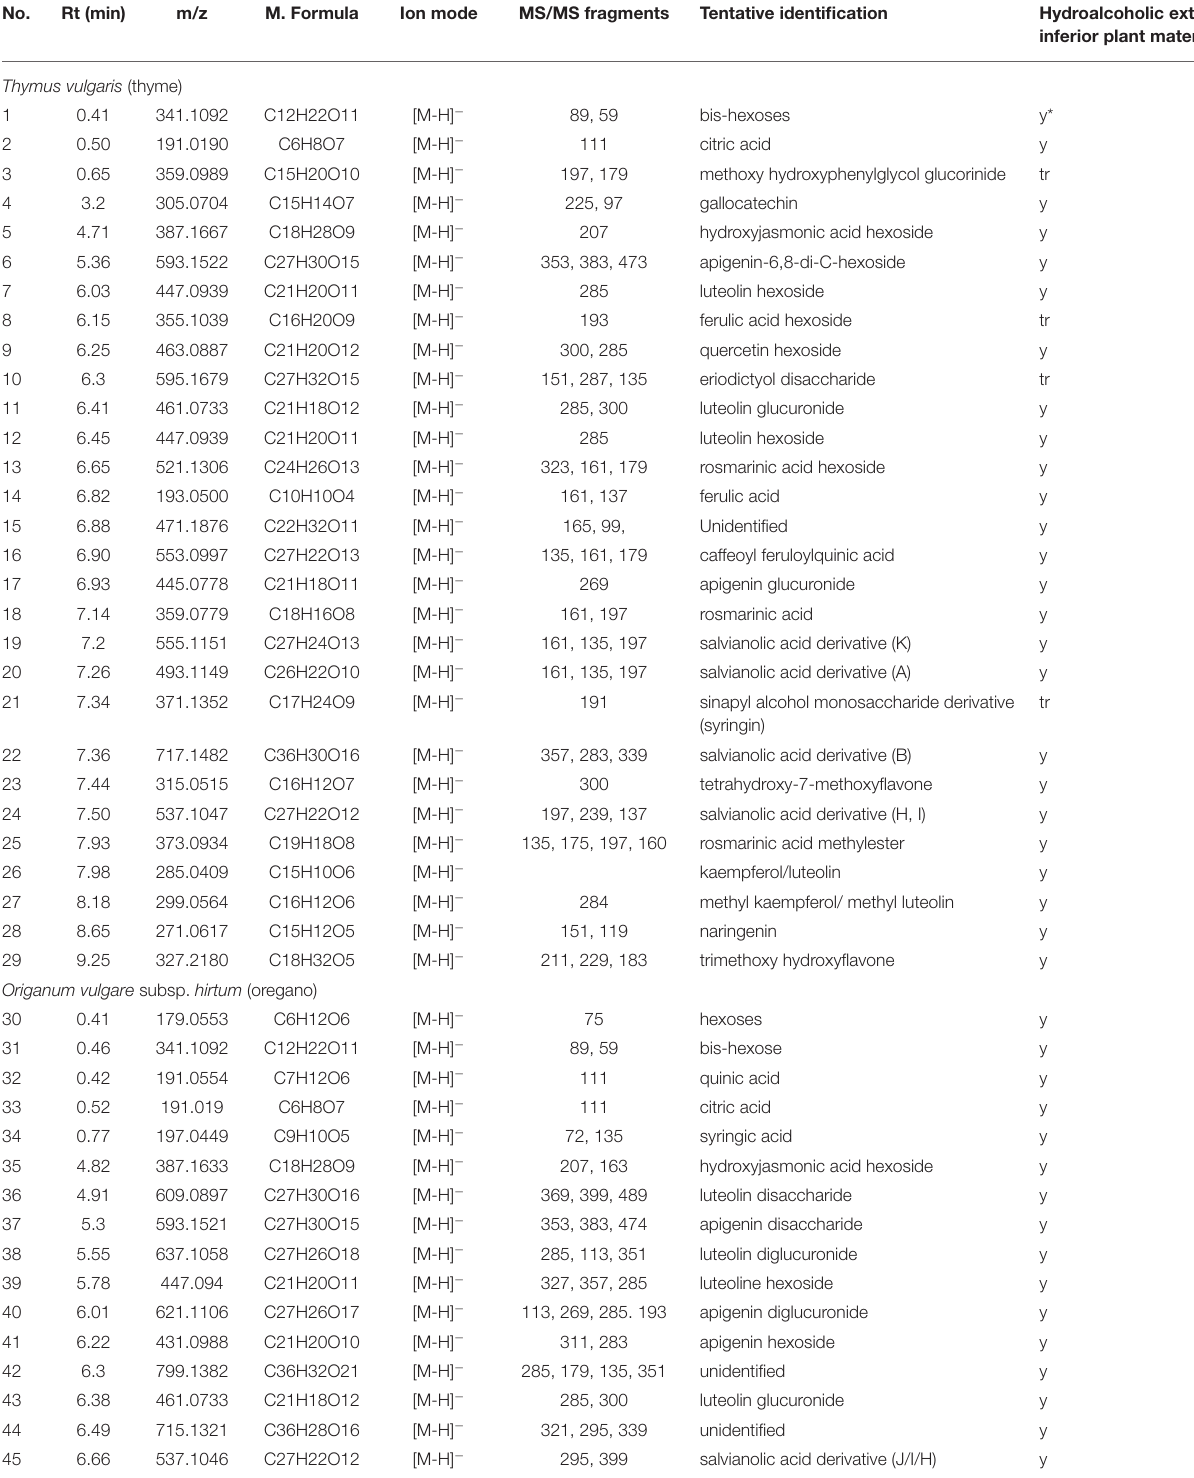
TABLE 3 | Liquid chromatography-mass spectrometry (LC-MS) based characterization of Thymus vulgaris (thyme), Origanum vulgare subsp. hirtum (oregano), Sideritis scardica (Greek mountain tea), and Matricaria recutita (chamomile) extracts obtained from the plant material of superior and inferior quality.